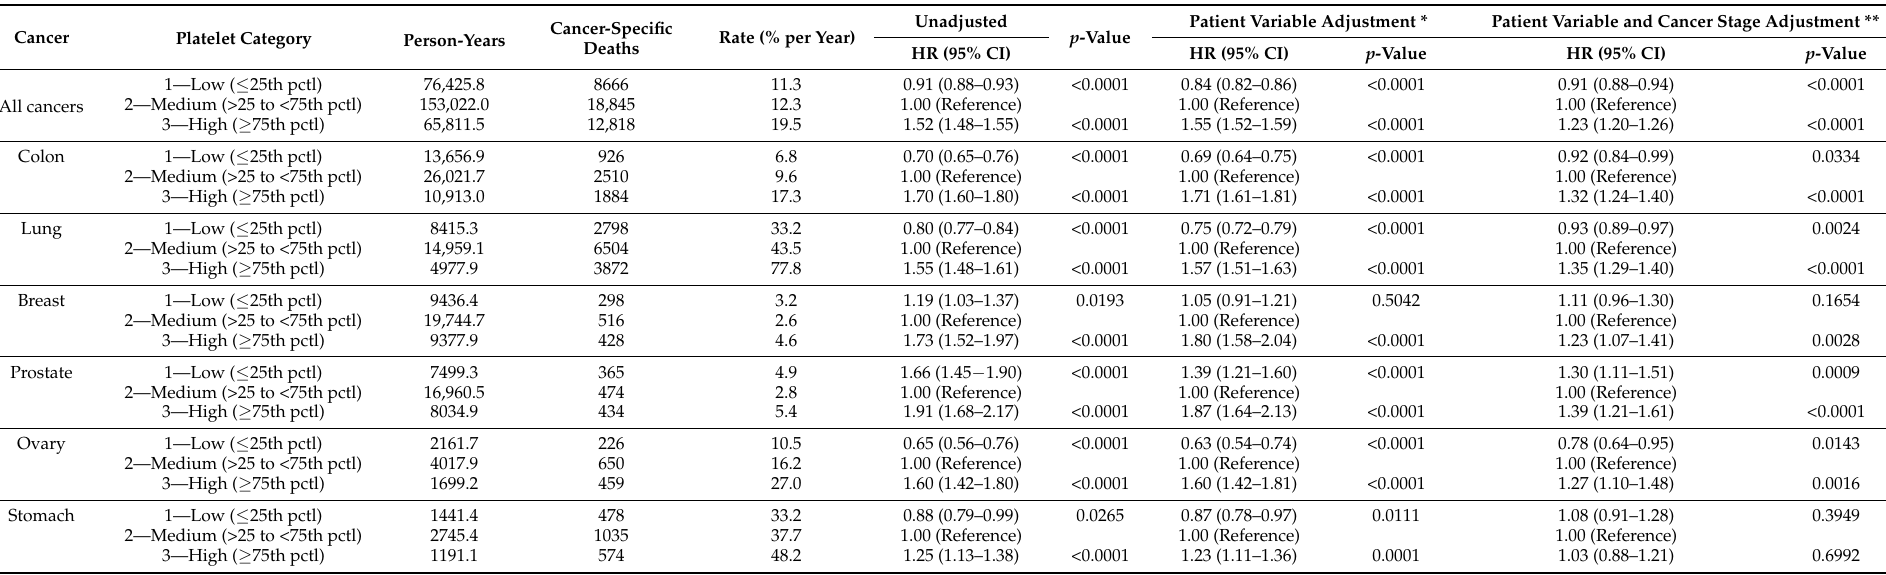
Table 2. Cancer-specific mortality rates and hazard ratios by baseline platelet count category for select